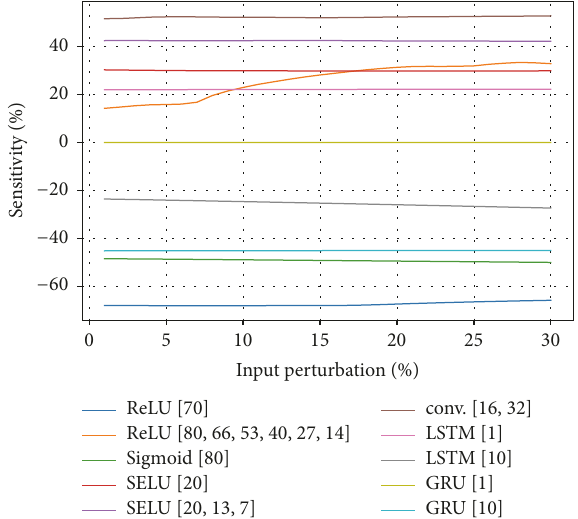
Figure 12: Trend in MASE for different LSTM RNNs.